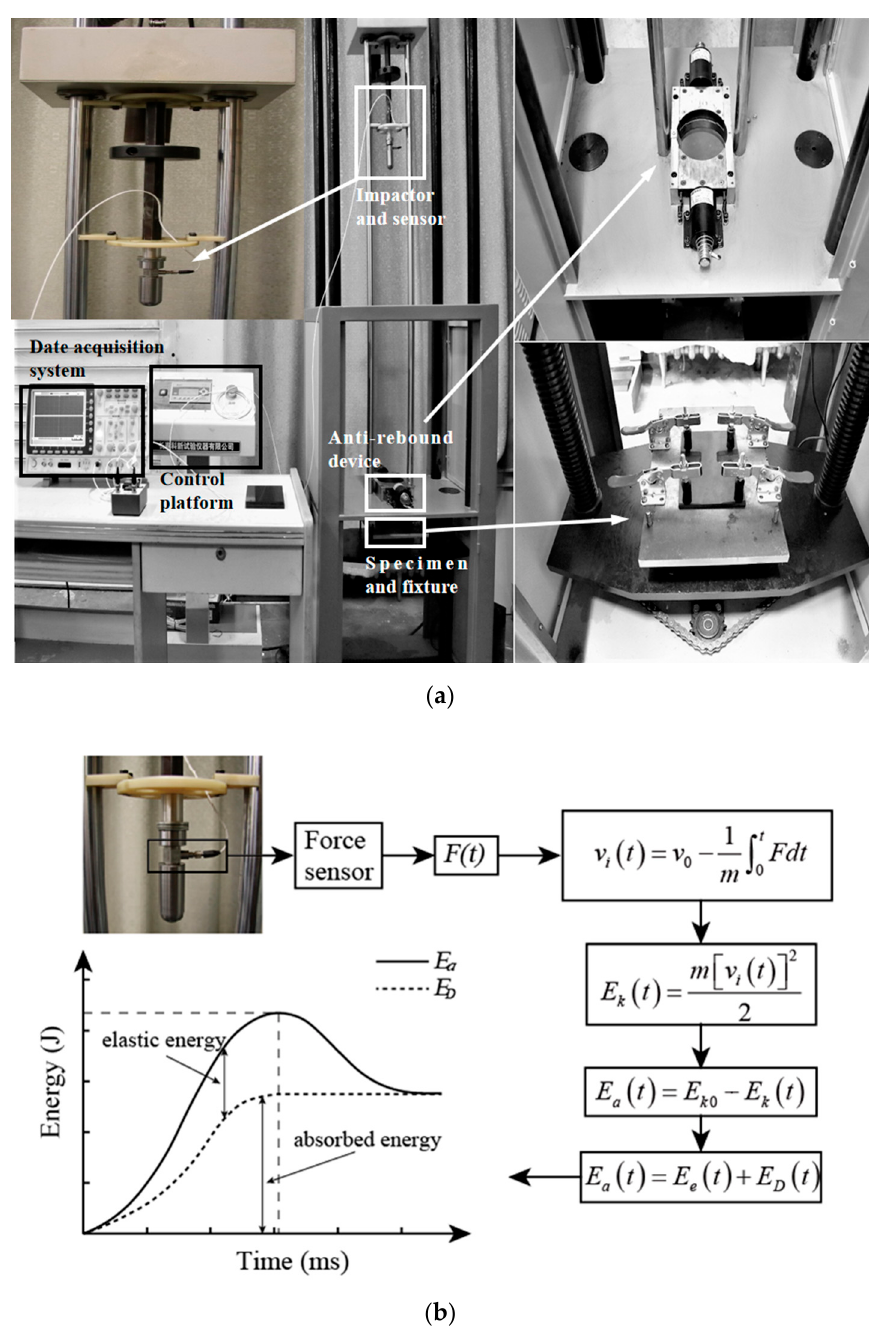
Figure 3. Low-velocity impact (LVI) test: ( a ) photograph of the system and ( b ) scheme of the experimental calculation.